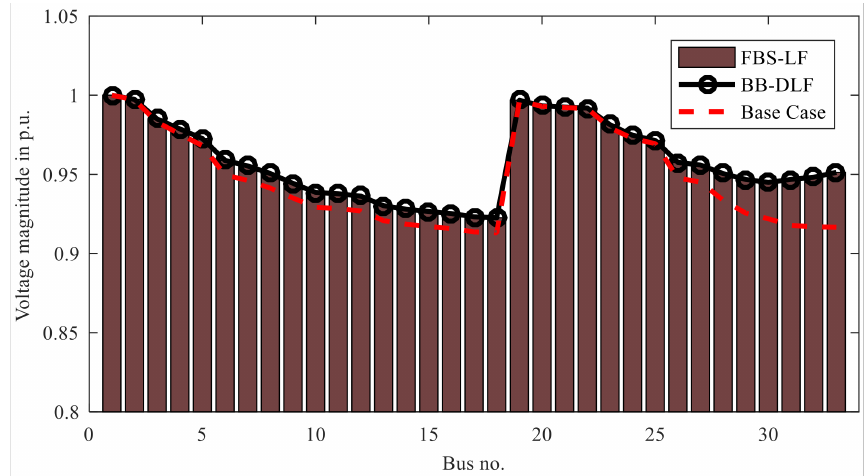
Figure 8. Comparison of voltage profile of PDN as obtained by FBS-LF and BB-DLF when a 1000 kVAr D-STATCOM is allocated to bus 33 of 33-bus PDN.